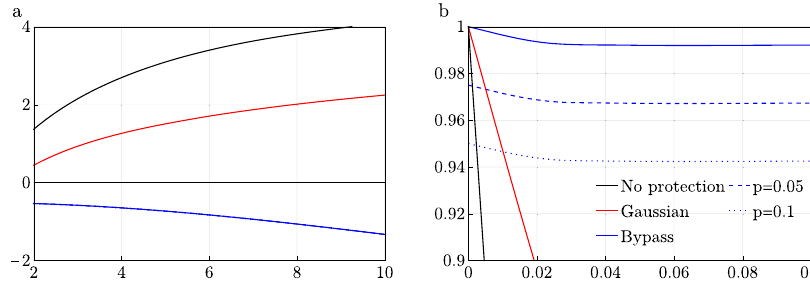
Fig. 2 Performance of bypass protection protocol in Fig. 1a for a superposition of two coherent states in a bosonic mode compared to the Gaussian strategy under various dephasings. a The logarithmic decay rate log γ of channel fi delity is modeled as F c ( η ) = F c (1)e − γ (1 − η ) for various cases. The curves for different p 's are overlapped. b Channel fi delity vs. loss parameter for α = 6. This result shows the qualitative difference between bypass and Gaussian